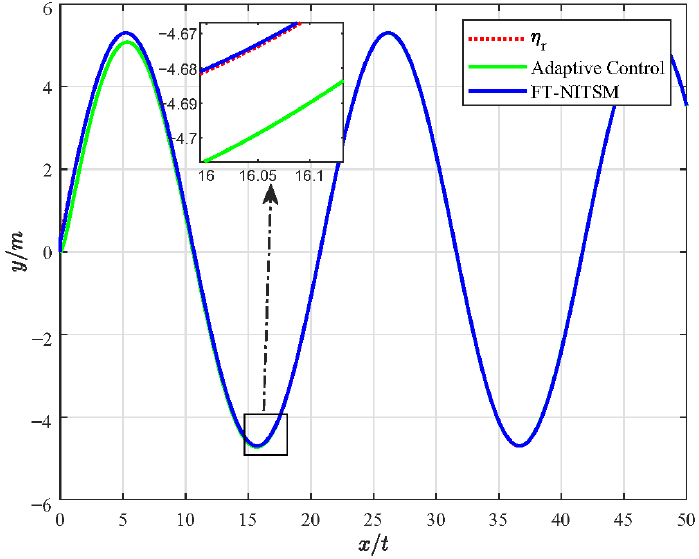
Figure 5. Comparison of resonant frequency tracking performance of FT-NITSM control and adaptive tracking control.